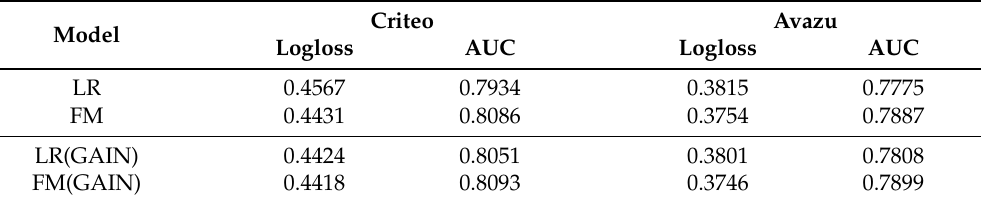
Table 3. Performance of transferring interactions selected by GAIN to LR and